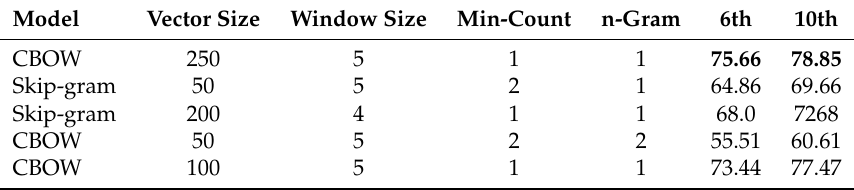
Table 8. Accuracies of the first ten instances without training in Domain 2 of the model using LSTM as a controller. On the APIMDS dataset, the best model is achieved by using feature vectors generated from the word2vec in the CBOW model with the parameters: n-gram of 1, vector-size of 250, window-size of 5, min-count of 1.